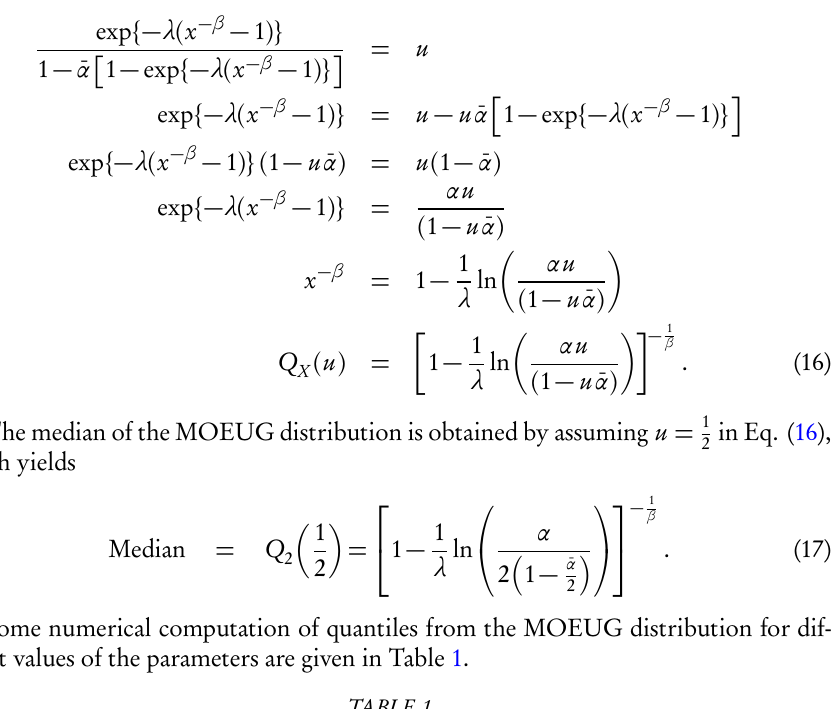
Some quantiles from the MOEUG distribution ( α = 2